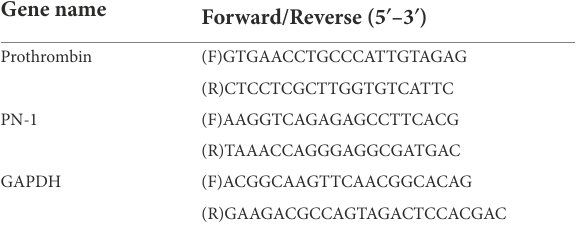
TABLE 1 Oligonucleotide primers used for qRT–PCR. Gene